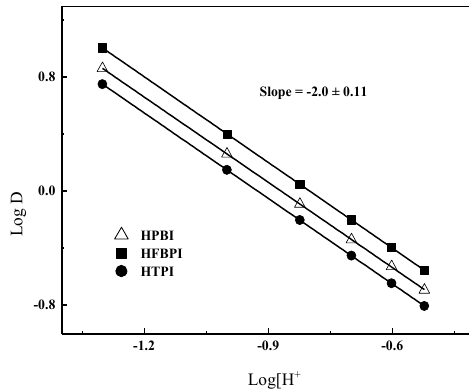
Figure 4. Effect of the H + concentration on Pd(II) extraction with 4-aroyl-3-phenyl-5- isoxazolones(HA). Aqueous phase = 1.12 × 10 -4 mol L -1 Pd(II) at 1.0 mol L -1 ionic strength, Organic phase = 1.0 × 10 -3 mol L -1 in CHCl , Equilibration time = 45 min. 3 The effect of the metal ion concentration (0.5  10 -4 – 2.8  10 -4 mol L -1 ) on the extraction process of Pd(II) from 0.05 mol L -1 hydrochloric acid solutions was examined using a range of 4-aroyl-3-phenyl-5-isoxazolones (1.0 × 10 -3 mol L -1 ) in chloroform. The results showed that